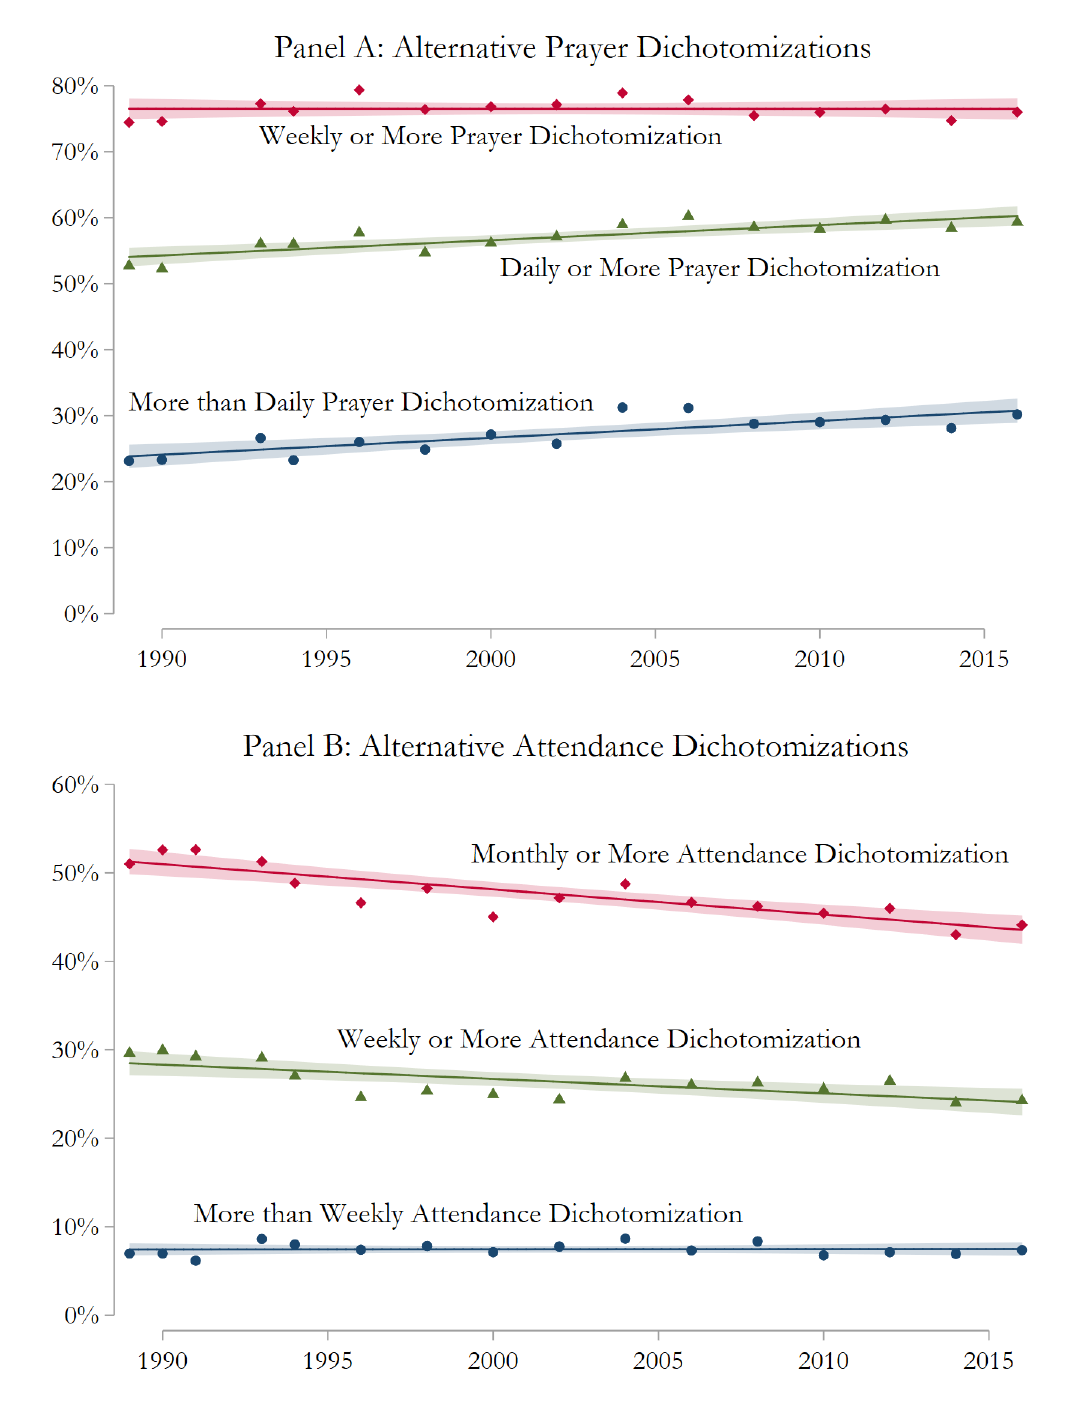
Figure 6: Alternative prayer and attendance frequency dichotomizations. Source: General Social Survey, 1989 to